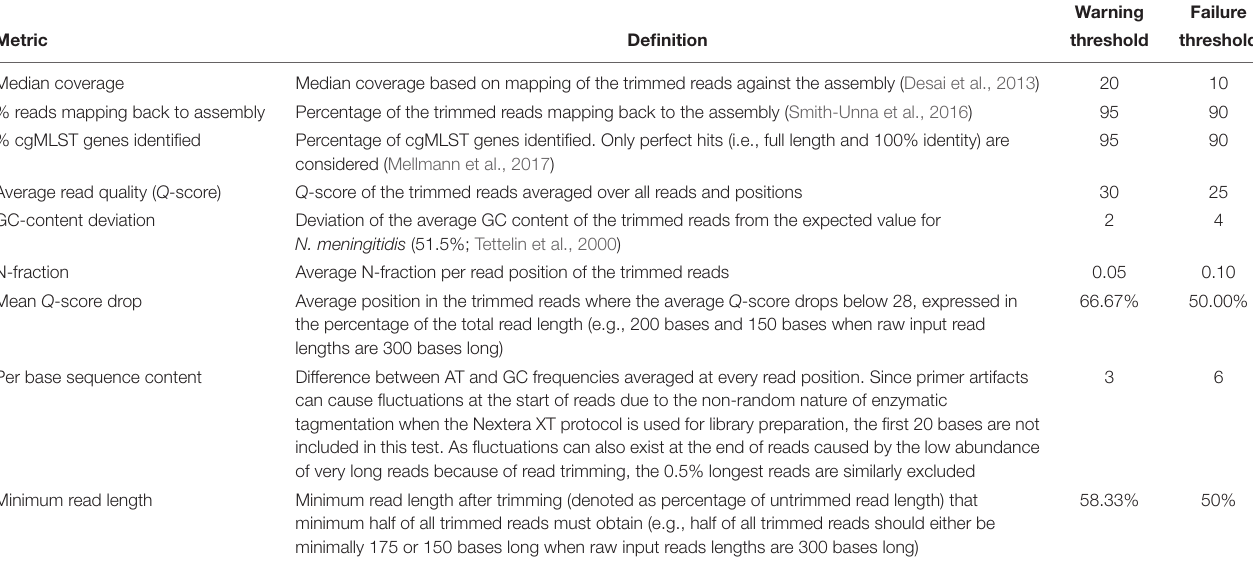
TABLE 1 | Advanced quality control metrics with their associated definitions and threshold values for warnings and failures.